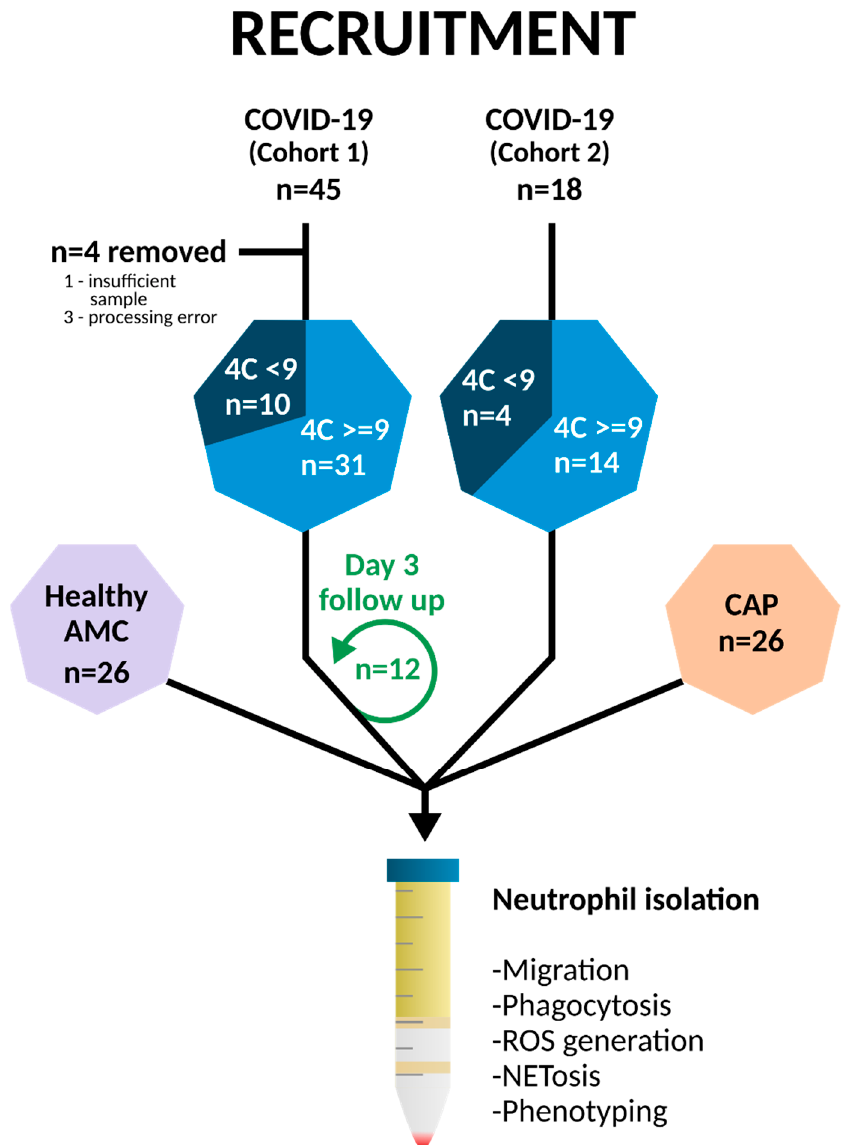
Figure 1. Patient recruitment. 45 hospitalised, non-ICU patients with COVID-19 were recruited from the Queen Elizabeth Hospital, Birmingham from January to March 2021 alongside 26 age matched controls (AMC) and 26 hospitalised patients with non-COVID-19 community-acquired pneumonia (CAP). Four COVID-19 patients were excluded, and 12 patients were re-sampled on days three to five post original sample. A second cohort of 18 COVID-19 patients was recruited between August 2021 and January 2022 for PI3K inhibitor studies. Blood was taken within 48 h of admission, and neutrophils were isolated by Percol density gradient centrifugation. Functional experiments including phagocytosis, NETosis, and phenotype were performed.